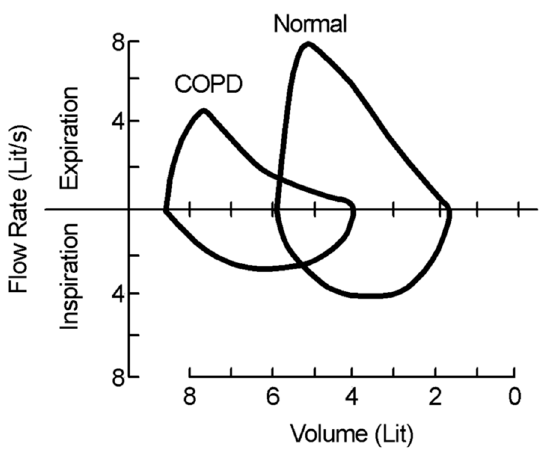
Figure 13. Identifying chronic obstructive pulmonary disease (COPD) from flow rate and volume data produced during a forced expiratory volume (FEV) test.